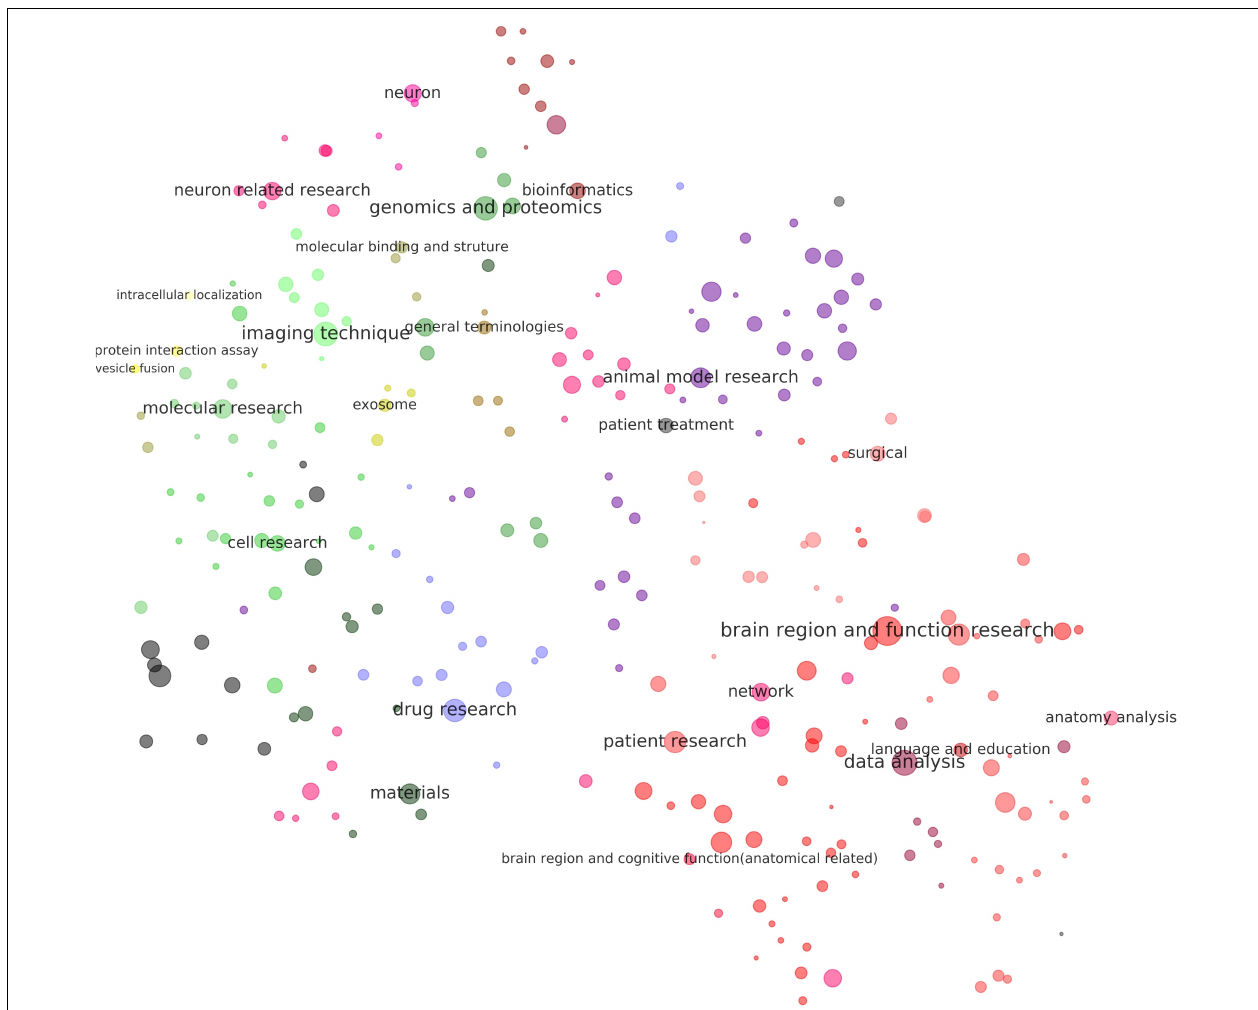
FIGURE 5 | Visualization of the results of clustering of methods related to neuroscience research. Each dot in the above figure represents a method cluster. The size of the dot represents the total number of references to methods in the cluster. The color of the dot represents level 3 of the cluster. The name of the cluster is provided on the largest dot under the level-3 cluster. Dot coordination was determined by the average word vector of terms in the cluster as calculated by the TSNE algorithm. More detailed results of the visualization of the same layout are given in Supplementary Material S8 , where all cluster names are